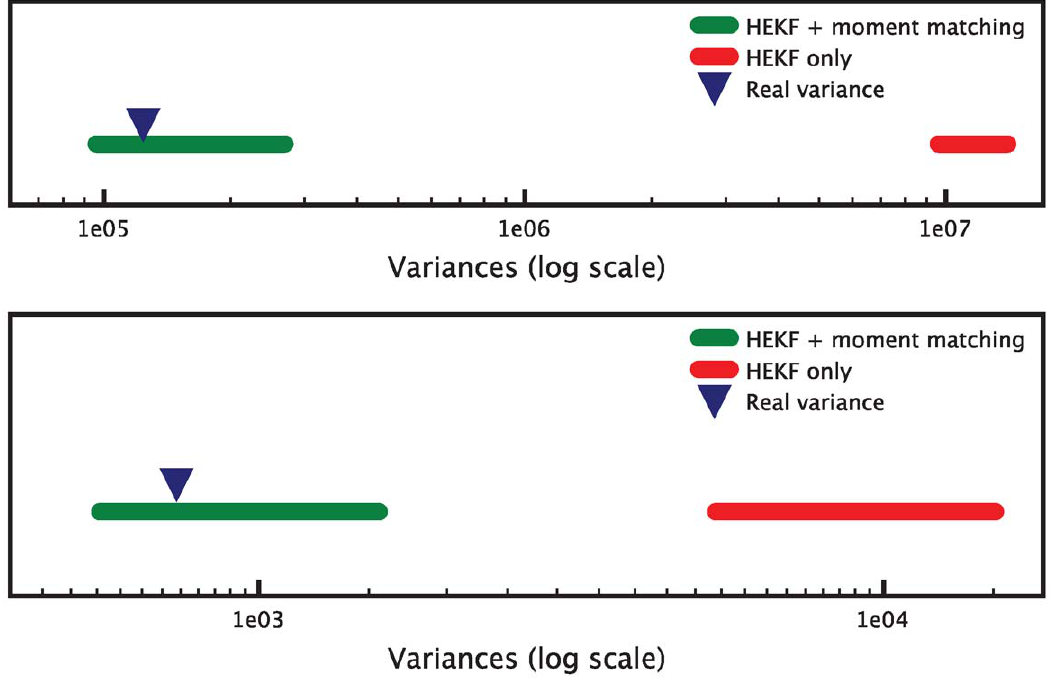
Figure 5. x 2 interval estimates in the case of valid and invalid parameter sets. The red set of interval estimates corresponds to a parameter set computed with the HEKF only (invalid). The green set corresponds to a parameter set that was obtained with the combination of HEKF and moment matching optimization (valid). The real variances (blue triangles) only lie inside the intervals corresponding to a valid estimation. The top panel is relative to the D t measurement signal, the bottom panel to the S t measurement